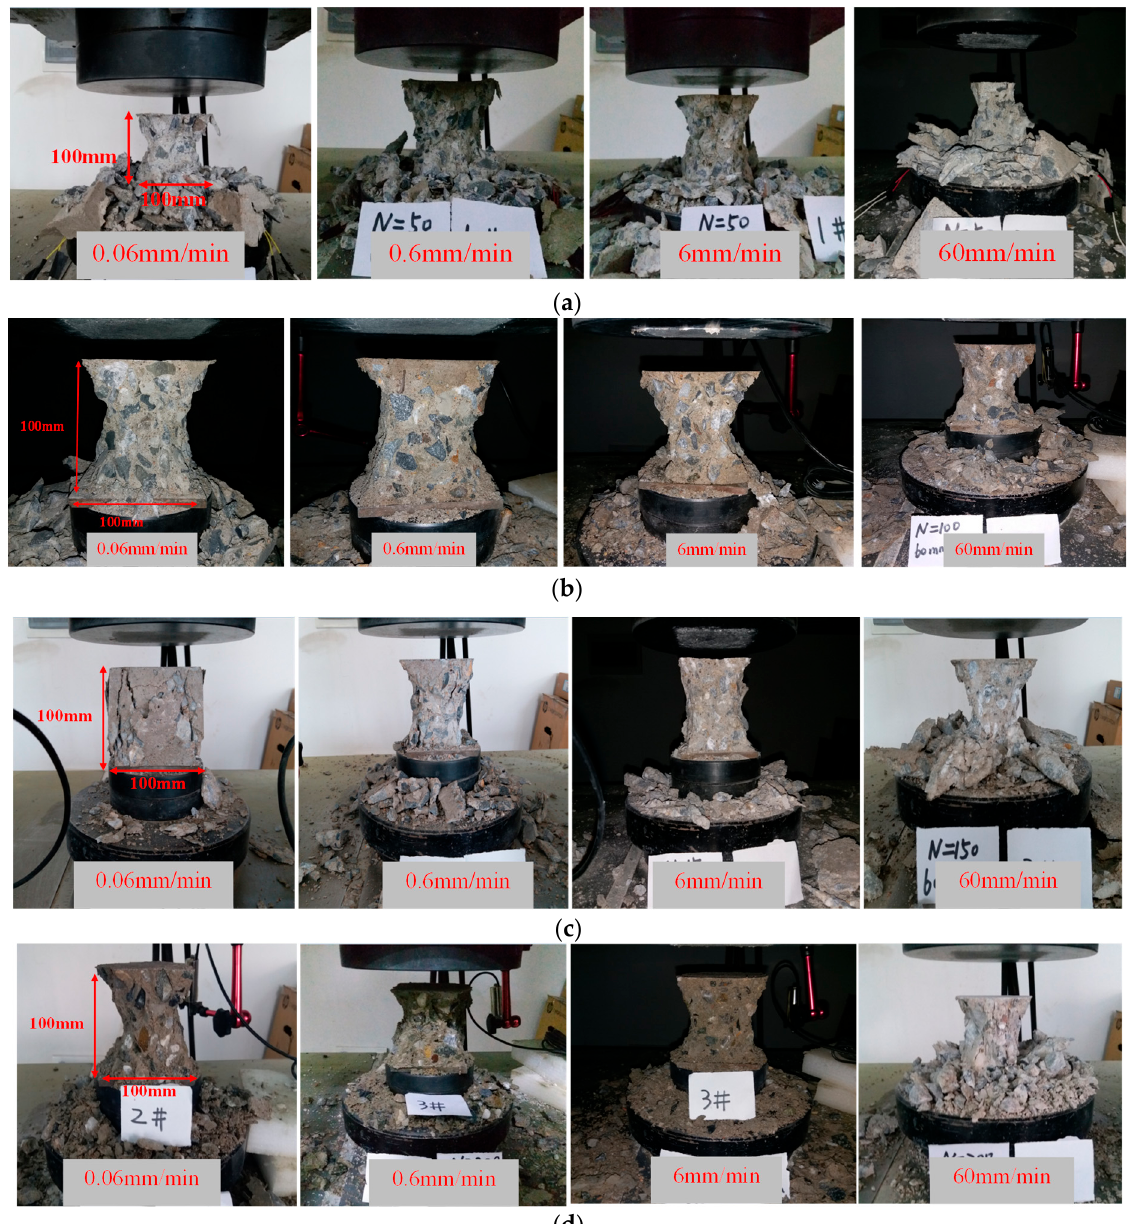
Figure 12. Failure modes with different strain rate and freeze–thaw cycles. ( a ) 50 freeze–thaw cycles, ( b ) 100 freeze–thaw cycles, ( c ) 150 freeze–thaw cycles, ( d ) 200 freeze–thaw cycles.